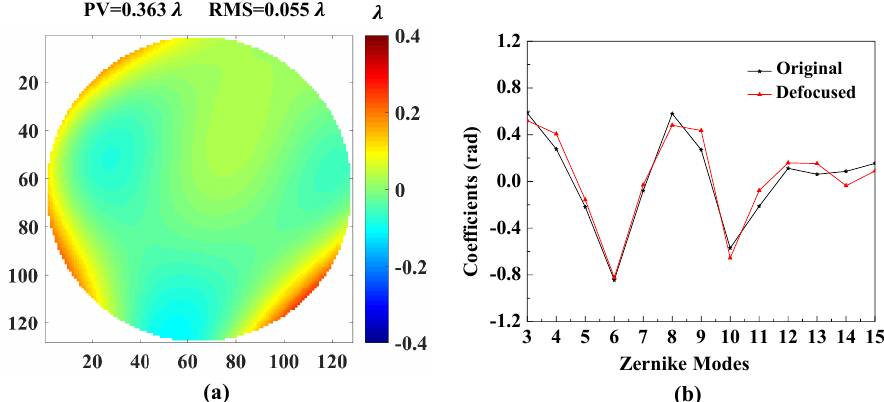
Figure 10. The result of the Defocused model of PD-CNN. ( a ) The residual wavefront and ( b ) the comparison of the Figure 8b and the estimated Zernike coefficients. The unit of residual wavefront is λ . The unit of estimated Zernike coefficients is rad.